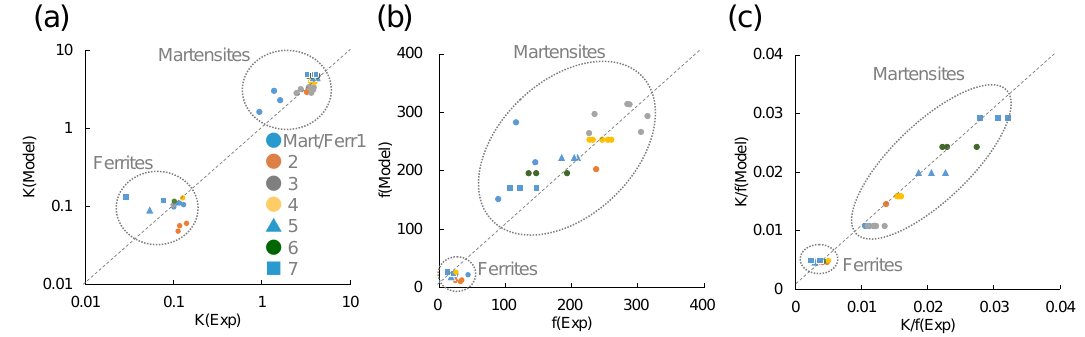
Figure 7. Model-Experiment plot for: ( a ) K ; ( b ) f ; and ( c ) K / f .